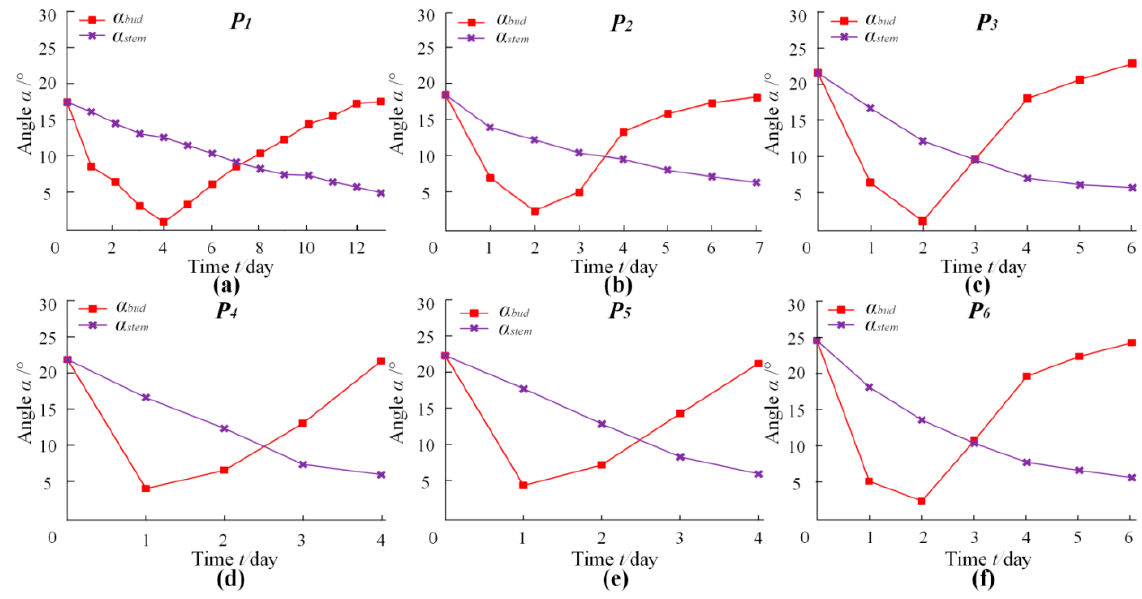
Figure 8. Variation rules for α bud and α stem with growth time for P 1 , P 2 , P 3 , P 4 , P 5 and P 6 ( a – f ).